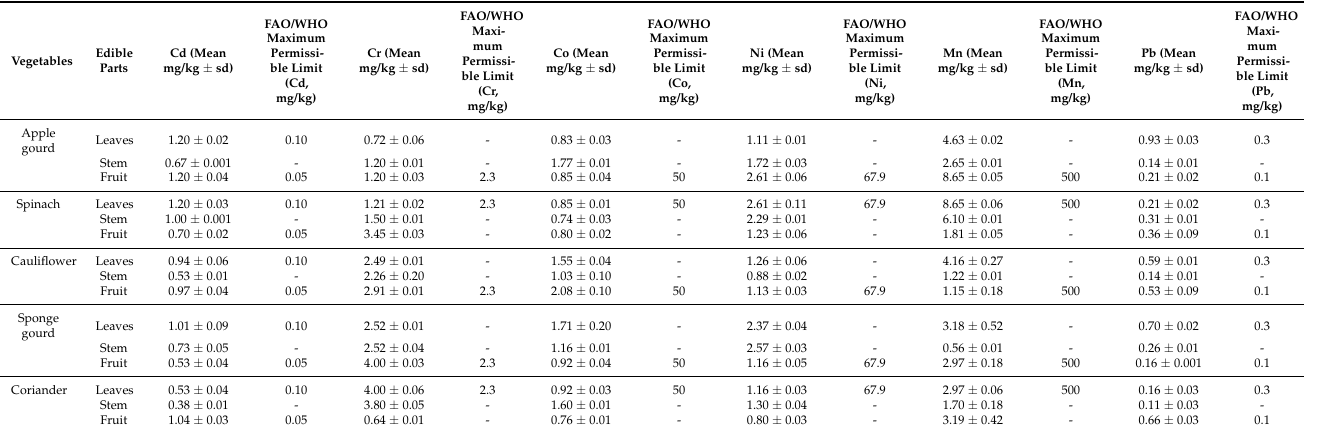
Table 2. The quantified concentration of heavy metals in vegetables and corresponding FAO/WHO maximum permissible